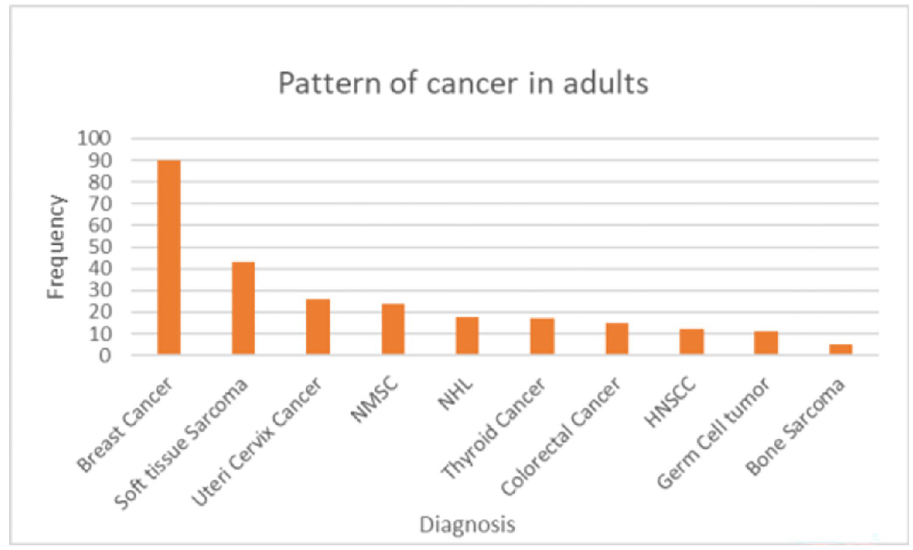
Fig 3. Cancer distribution pattern in adults in Wolaita Sodo University Hospital, 2021. NMSC—Non Melanomatous Skin cancer, NHL- Non-Hodgkin lymphoma. HNSCC—Head and Neck squamous cell cancer.